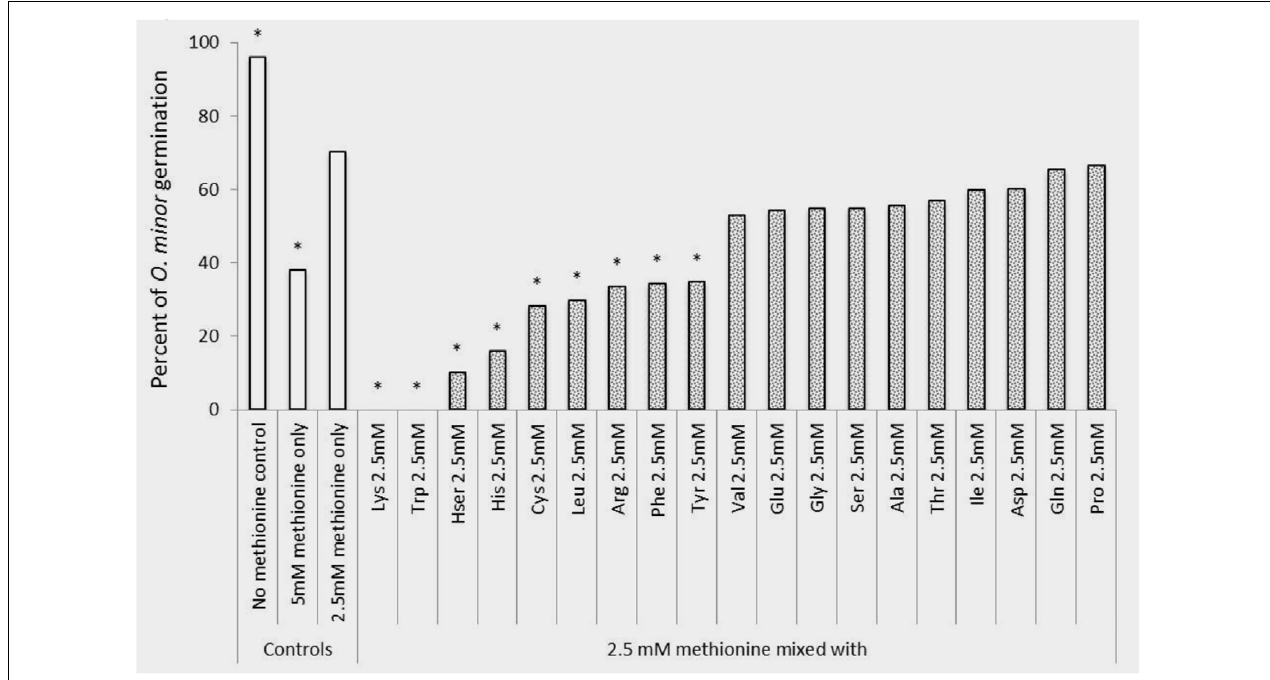
FIGURE 5 | Rescue of methionine inhibition of O. minor germination induced by application of 2.5mM of alanine, arginine, aspartate, cysteine, glutamic acid, glutamine, glycine, histidine, homoserine, isoleucine, leucine, lysine, methionine, phenylalanine, proline, serine, threonine, tryptophan, tyrosine, and valine. ∗ Indicates differences of each treatment compared with the control (germination observed in 2.5 mM methionine treatment) assessed by Dunnett’s test at the 0.05 level.